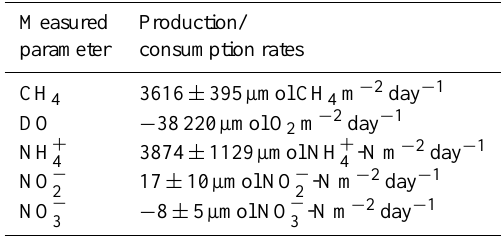
CH 4 , NH + 4 , NO − 2 , NO − 3 production/consumption rates were determined between hour 0 and 288 of the incubation experiment. The DO rate was determined between hour 0 and 48 of the incubation